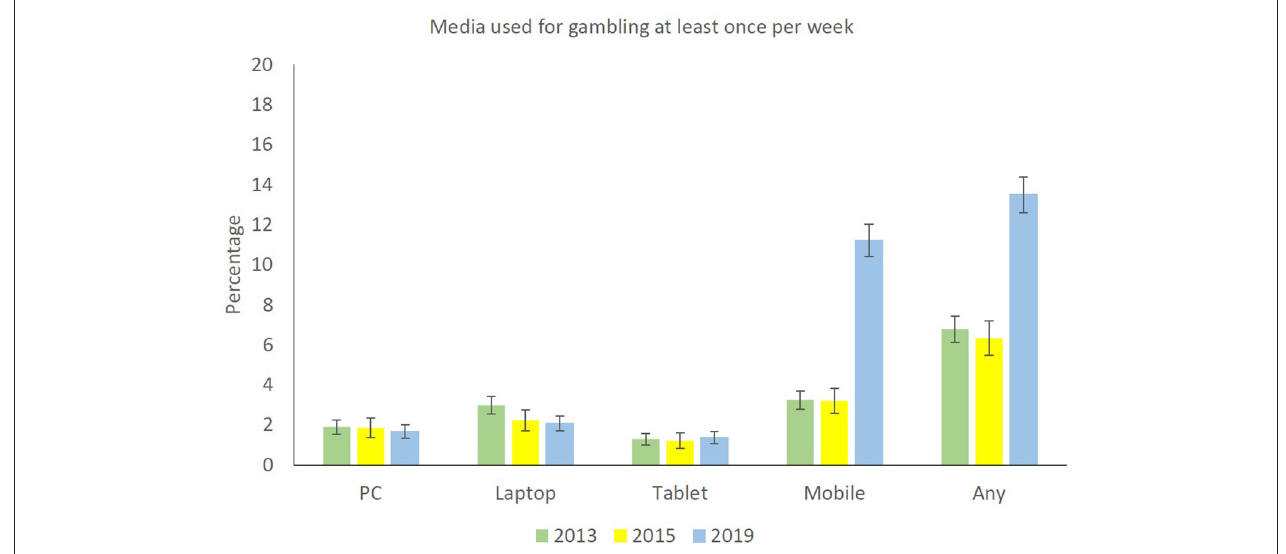
FIGURE 2 | Online gambling at least once per week among gamblers, broken down by year and mode of Internet access for gambling.